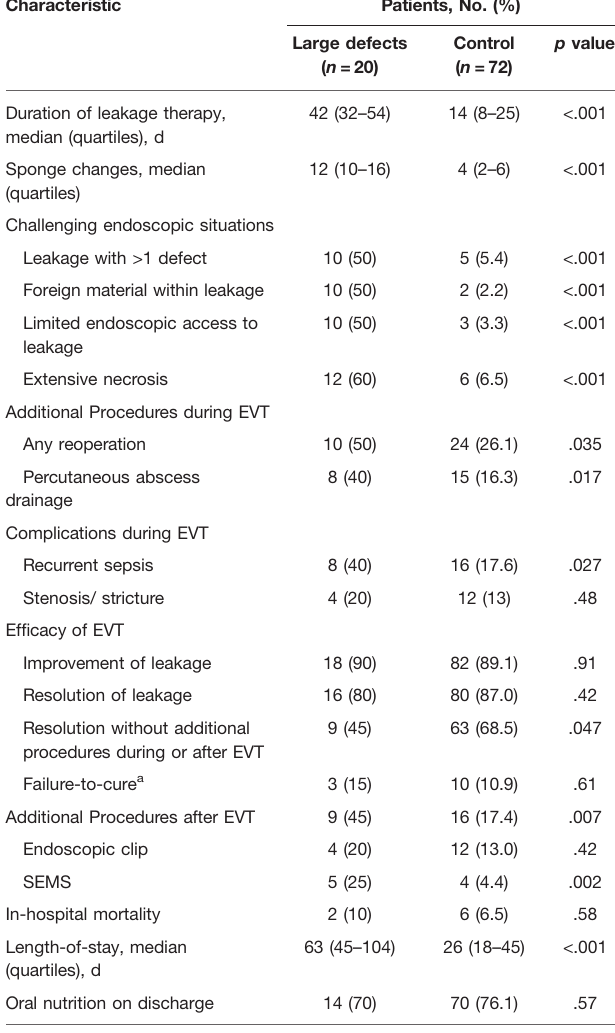
TABLE 2 | Endoscopic leakage therapy and